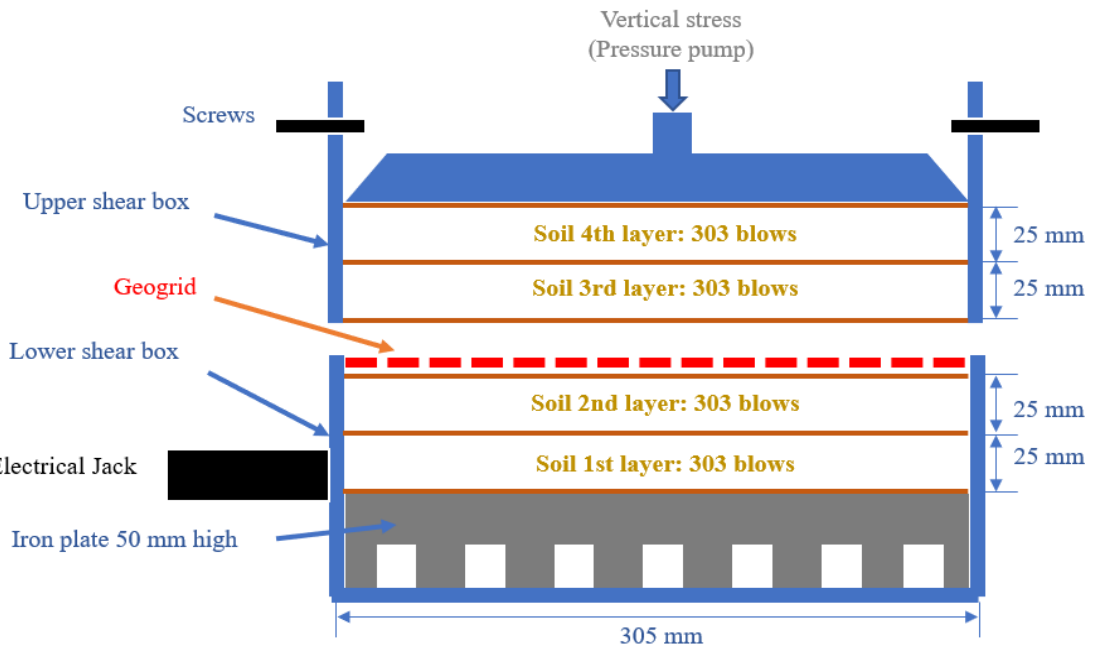
Figure 8. The position of the geogrid in the large - scale direct shear apparatus. The testing results obtained from the large - scale direct shear test were normal stress, vertical displacement, horizontal force, and horizontal displacement. The shear stress was calculated from Equation 2 as follows: The density of the compacted-soil sample in the box of large-scale direct shear was tested by the sand cone method for determining the relative compaction (RC). where: